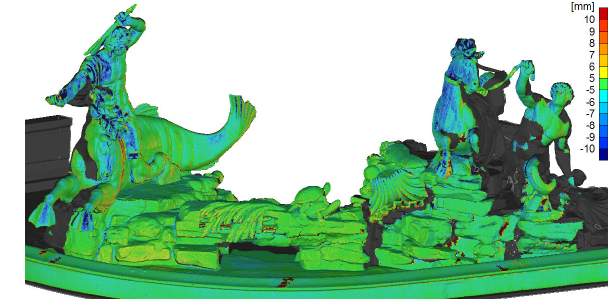
Figure 10. Discrepancies between a single point-cloud (scanning position 6) and the final documentation model.